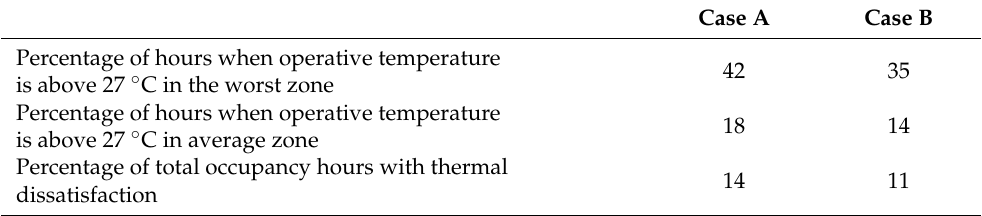
Table 11. Comparison of the overall thermal comfort data in case A (no low-E film) and case B (with low-E film) including all occupied